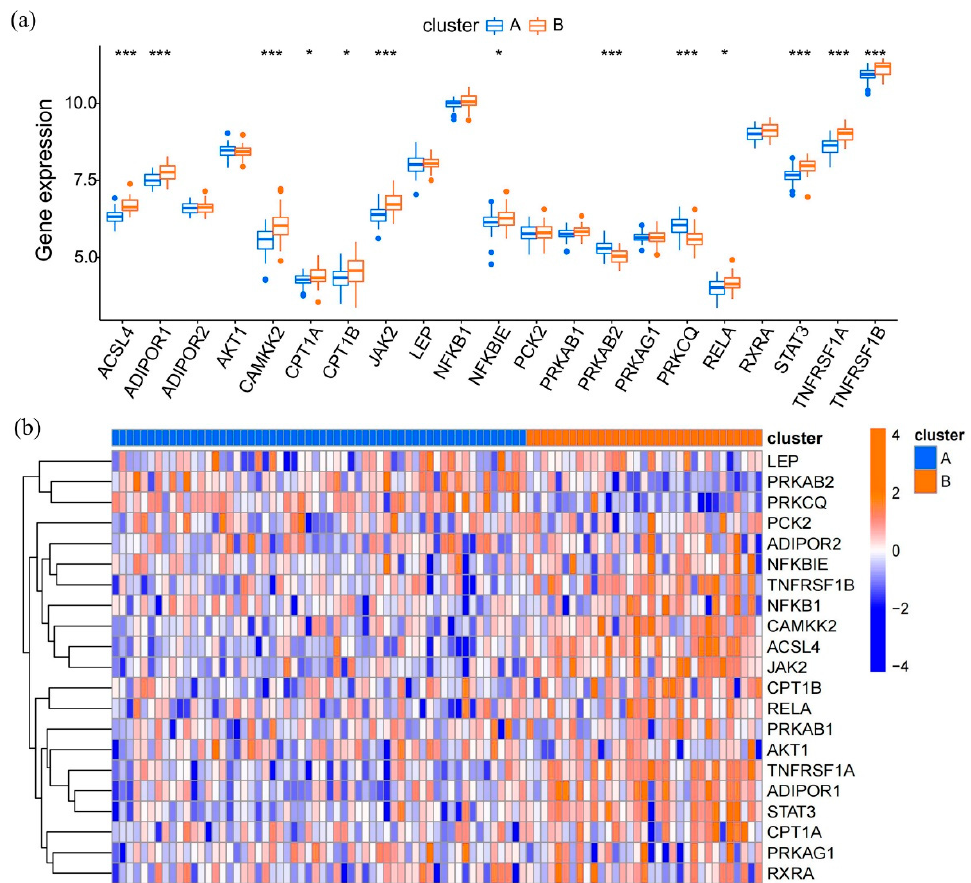
Figure 6. Expression of adipocytokine signaling pathway among different expression patterns in epilepsy samples. ( a,b ) A boxplot and heatmap show the expression levels of these 21 genes in cluster A and B. * p < 0.05, *** p < 0.001.